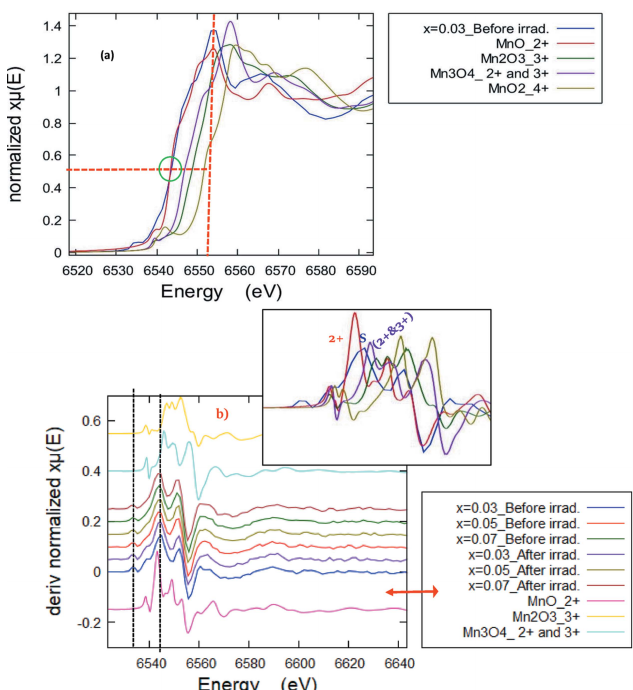
Figure 7 ( a ) Normalized fingerprint XANES spectra for x = 0.3 before irradiation along with the reference Mn compounds (with y -offset for clarification). ( b ) First derivative of Mn K -edge XANES spectra of Mn-doped ZnO samples before and after irradiation at different x along with those of reference Mn compounds. The inset is a zoom without